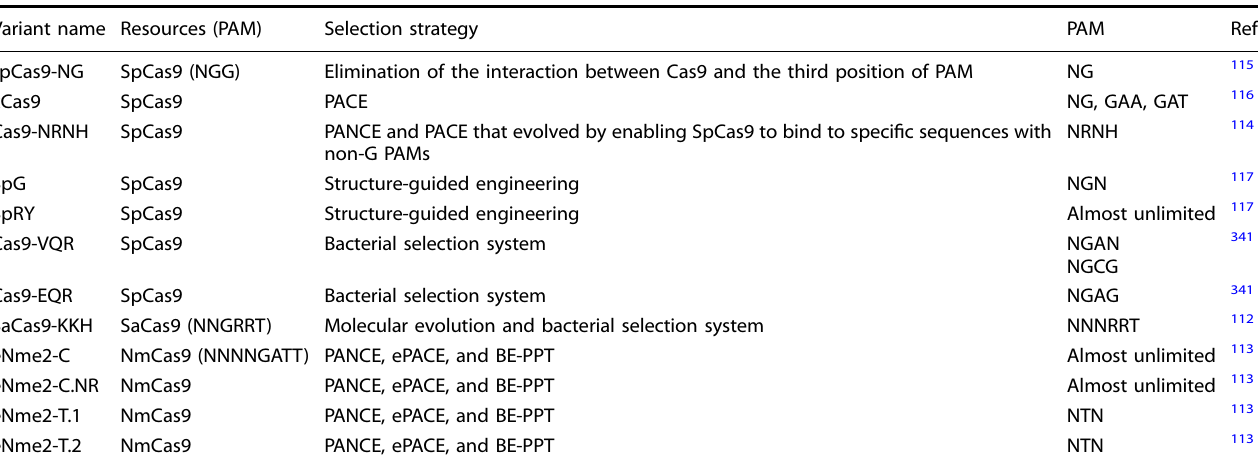
Table 1. Cas9 variants that have been modi fi ed to broaden the scope of application